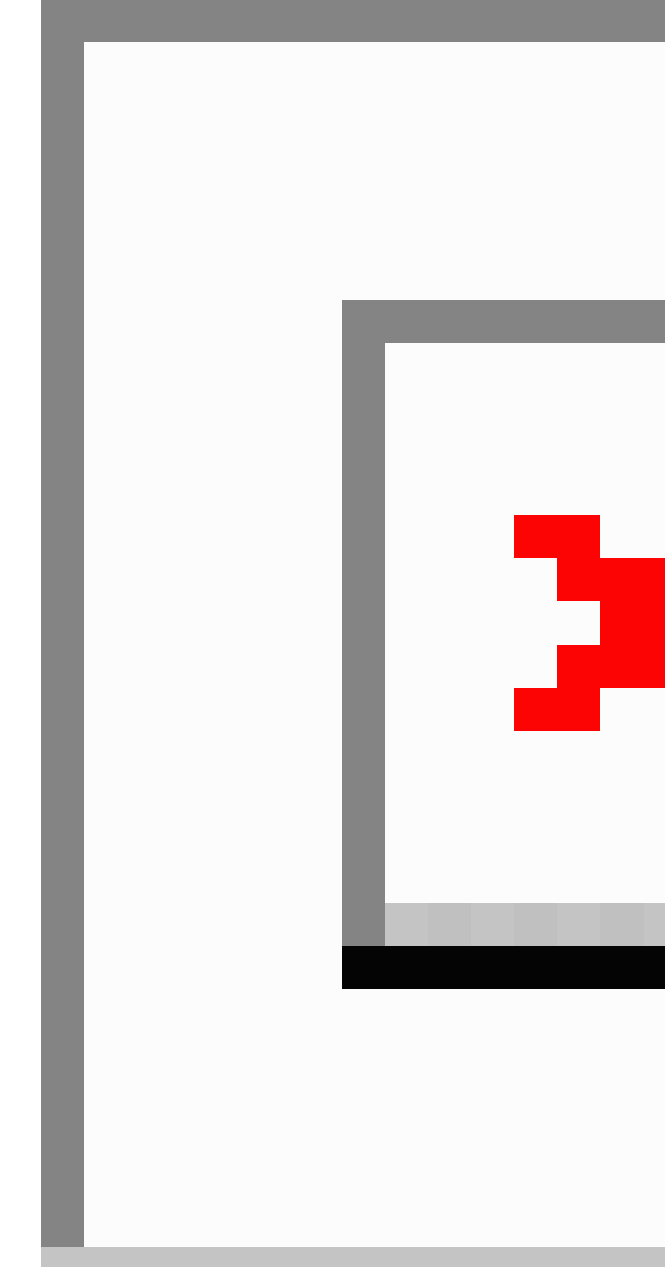
Figure 2. Overview of the study flow from Phase 1 to Phase